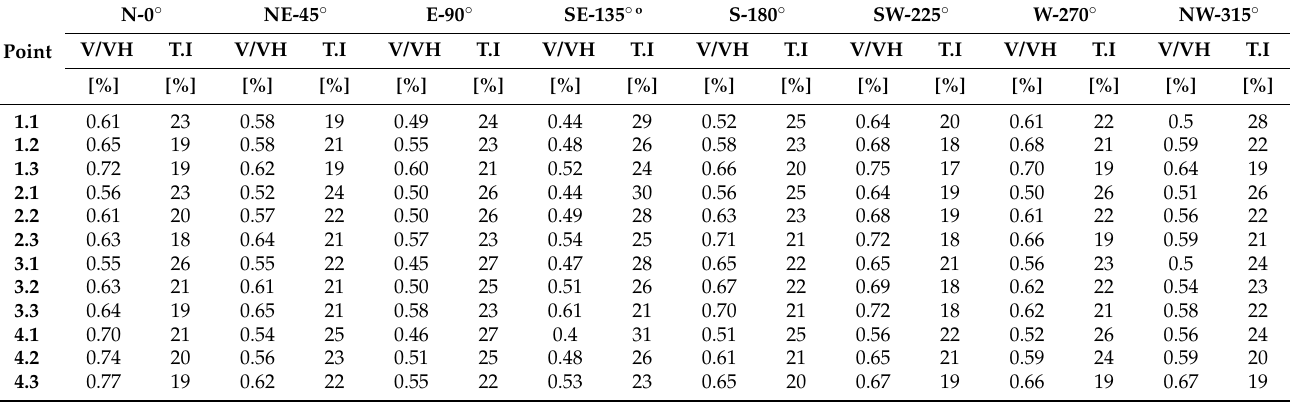
Table 4. Wind tunnel results per direction per point (1 to 11) and per height. V/VH is the ratio between velocity (V) and velocity at the top of the boundary Layer (VH); TI is the turbulence